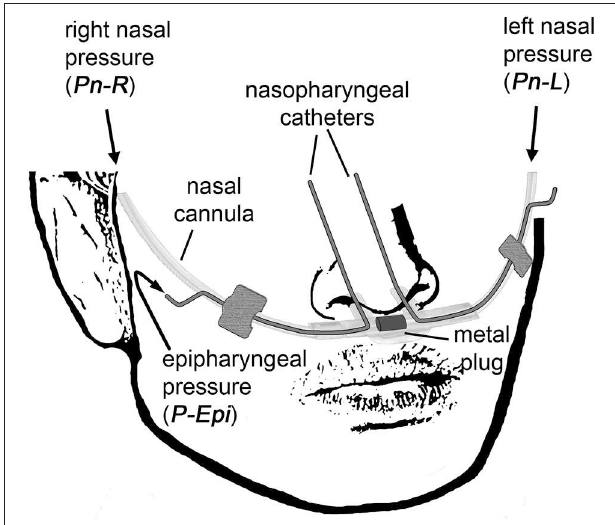
FIGURE 1 | The customized catheter system for non-invasive continuous side-selective monitoring of nasal airflow and conductance. The measured signals are left nasal pressure ( Pn L ), right nasal pressure ( Pn R ), and epipharyngeal pressure ( P Epi